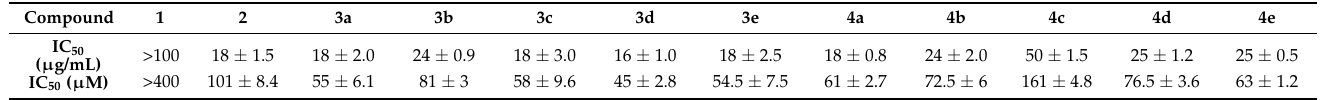
Table 3. Anti-proliferative activity of compounds tyrosol-alkyne ( 1 ), cycloadducts ( 2 ), ( 3a – e ) and ( 4a – e ) on the K562 tumor cell line.